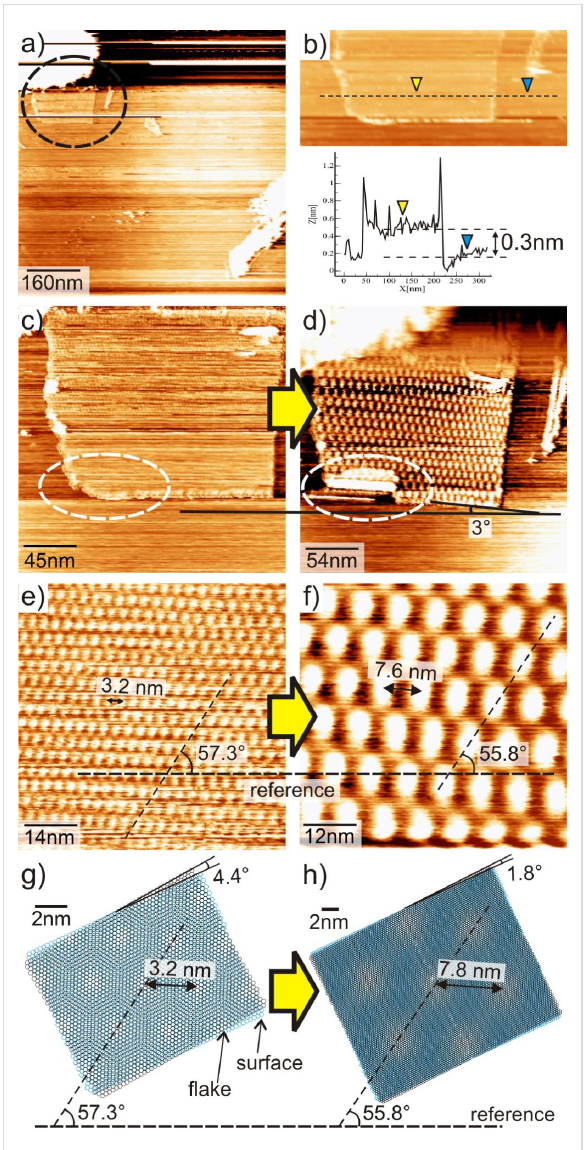
Figure 1: (a) STM image of a 160 nm wide, one-layer thick graphene flake (encircled); (b) cut out portion and height profile along the dashed line on the graphene flake. Zoomed-in region imaged by STM: (c) before rotation of the flake, (d) after a rotation by ca. 3°. (e) and (f) are STM images showing the lattices within the flake in (c), and (d) respectively. (g) and (h) are models for the superlattices in (e) and (f) respectively. Imaging parameters for (a,c,e) are 190 mV, 0.6 nA and (d,f) are 80 mV and 0.6